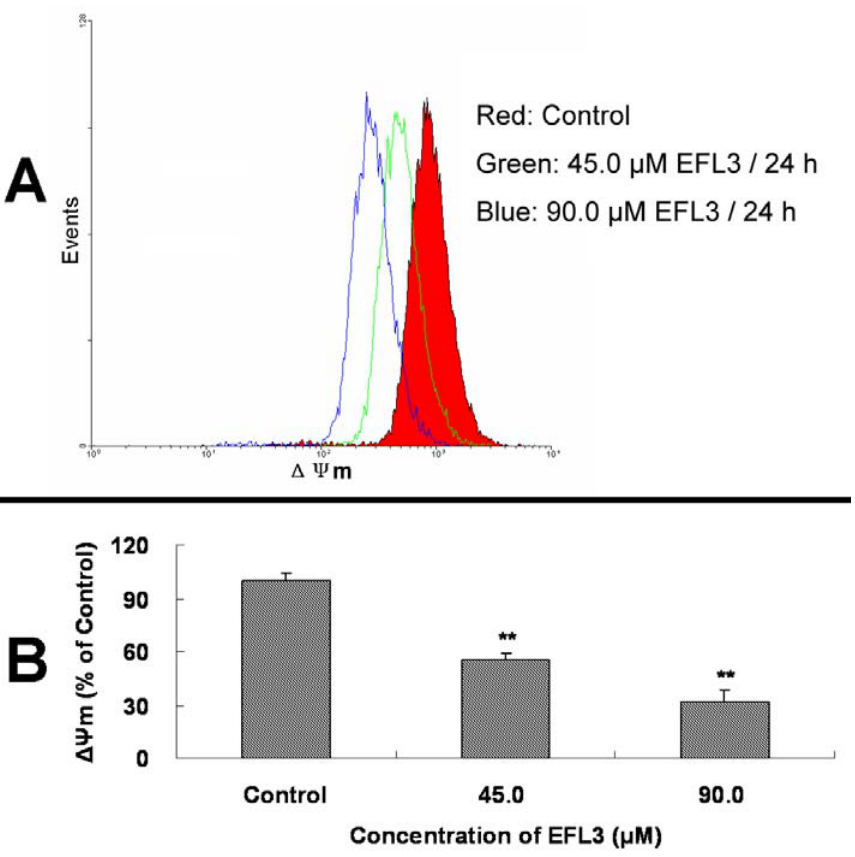
Figure 5. EFL3 treatment caused loss of ΔΨ in A549 cells. (A) The decreases of ΔΨ m A549 cells. (B) ΔΨ levels were calculated as percentage of control. Data were expressed m as means ± SD of at least triplicate determinations. * P < 0.05 and ** P < 0.01 vs. the